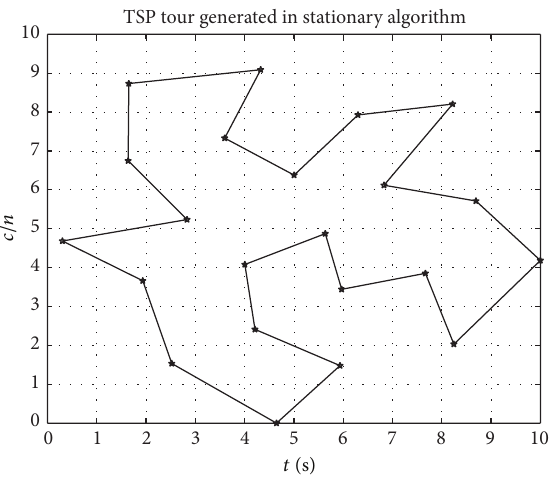
Figure 11: High amount of time and distance cost are needed to complete the tour vis-a-vis when prediction is